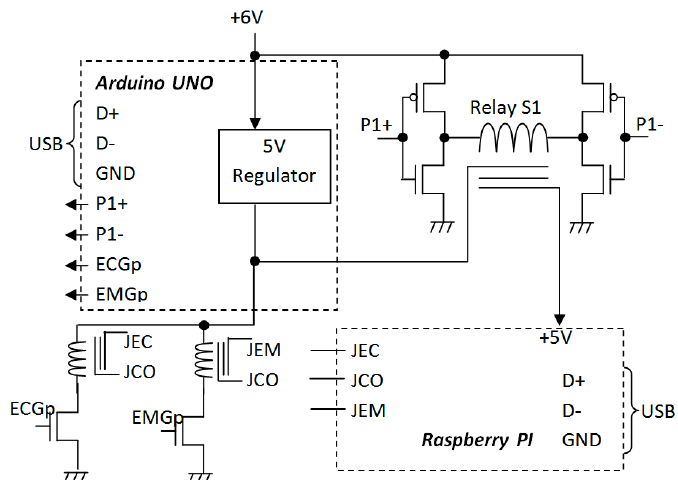
Figure 5. Block Diagram of Arduino and external relays for sensor selection and sleep intervals implementation.